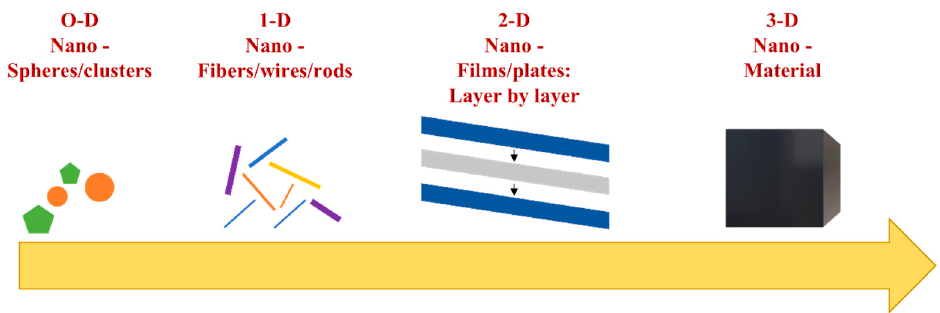
Figure 1. Classification of nanomaterials regarding their dimensions.